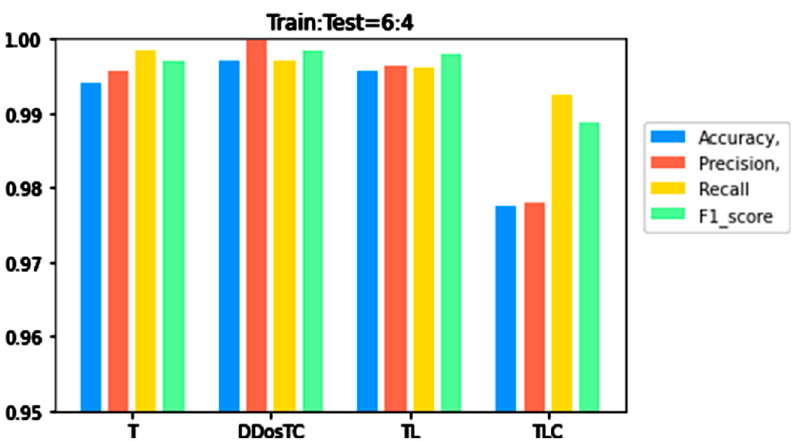
Figure 7. A performance comparison of DDosTC and transformer, transformer + CNN + LSTM, and transformer + LSTM (Train/Test = 7:3).